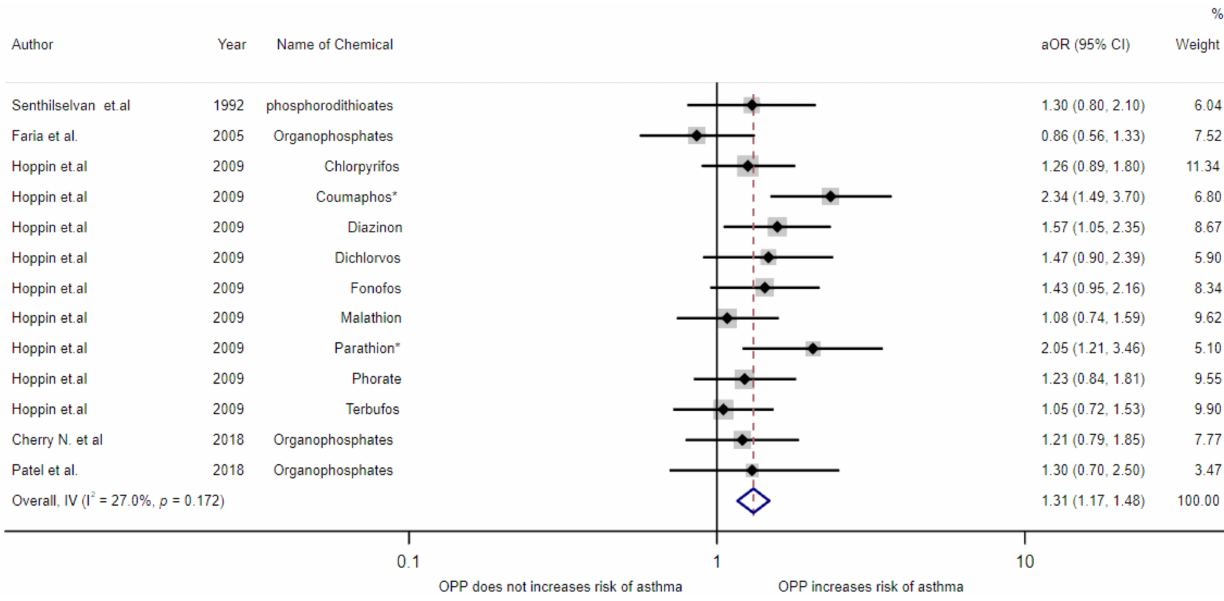
Figure 2. Meta-analysis of exposure to organophosphates and asthma disease. * p < 0.05.